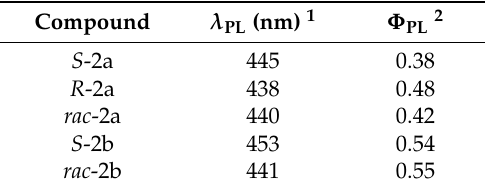
Figure 7. ( a ) PL spectra for 2a and 2b in the crystalline phase. ( b ) Photographs of PL under UV irradiation ( λ ex = 365 nm) and CIE chromaticity diagram for the PL colors. Table 3. Photophysical data of 2a and 2b in the crystalline phase.